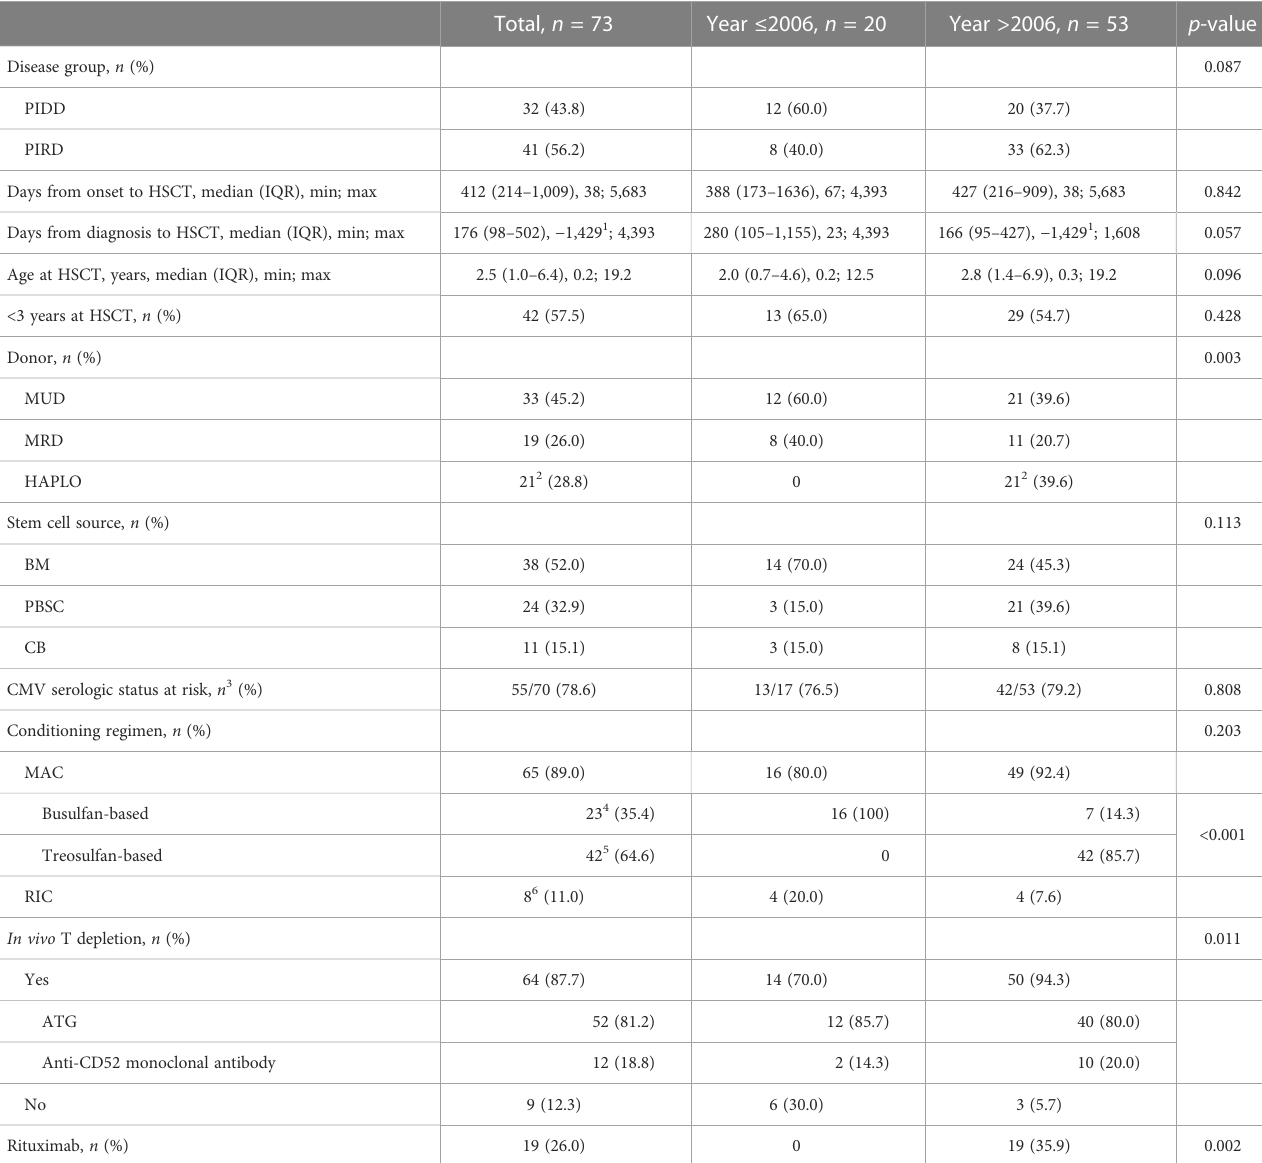
TABLE 2 Details of the 73 HSCTs according to HSCT year ( ≤ 2006,